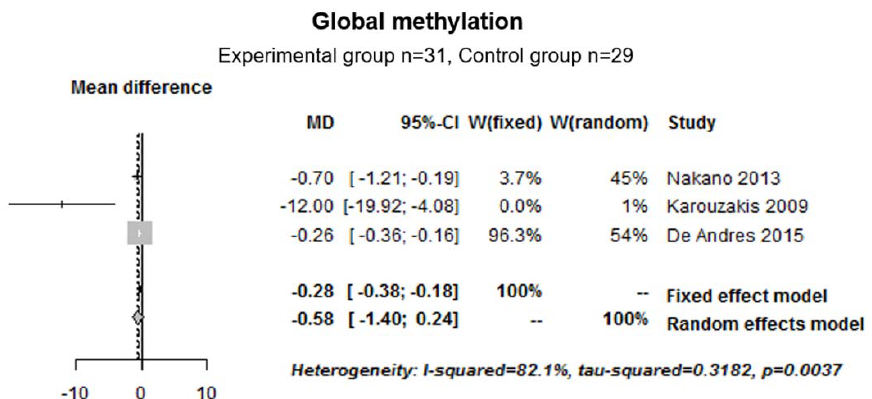
Figure 7. Forest plot for global methylation in human cell cultures.